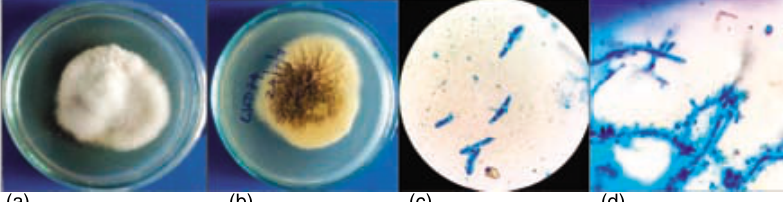
Fig. 1 . T. mentagrophyte ; a. Flat, white to cream powdery colony; b. Yellow-brown colour pigment on reverse; c. Single-celled microconidia; d. pencil shaped macro conidia.